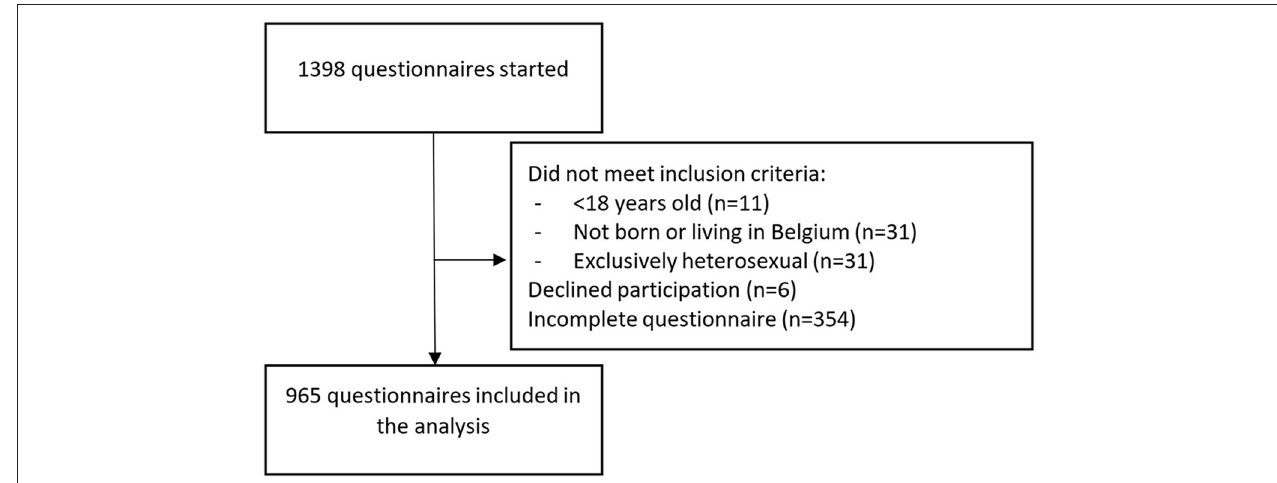
FIGURE 1 | Sample